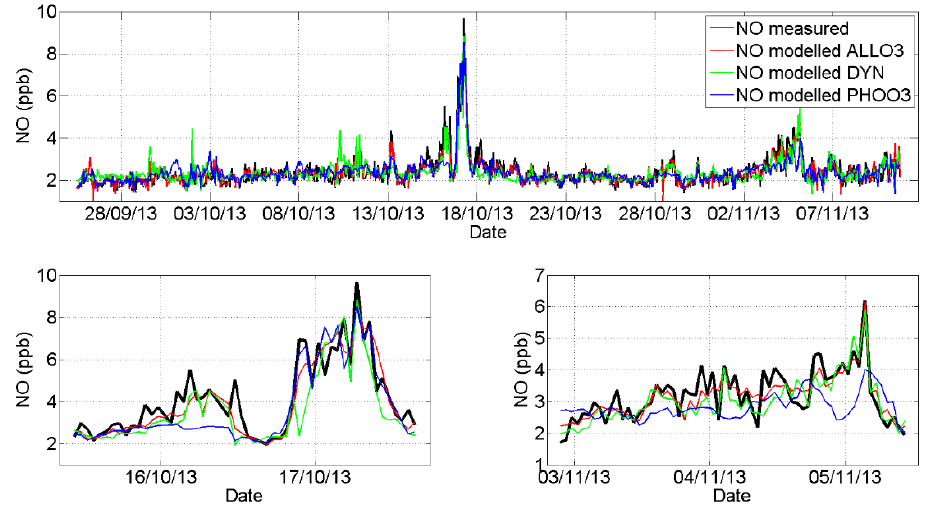
Figure 4. Upper panel: Time series of measured and modeled nitrogen oxide with three different scenarios for the input nodes (see text for more details). Lower panels: temporal magnification of the upper panel time series to highlight the three peaks of NO.